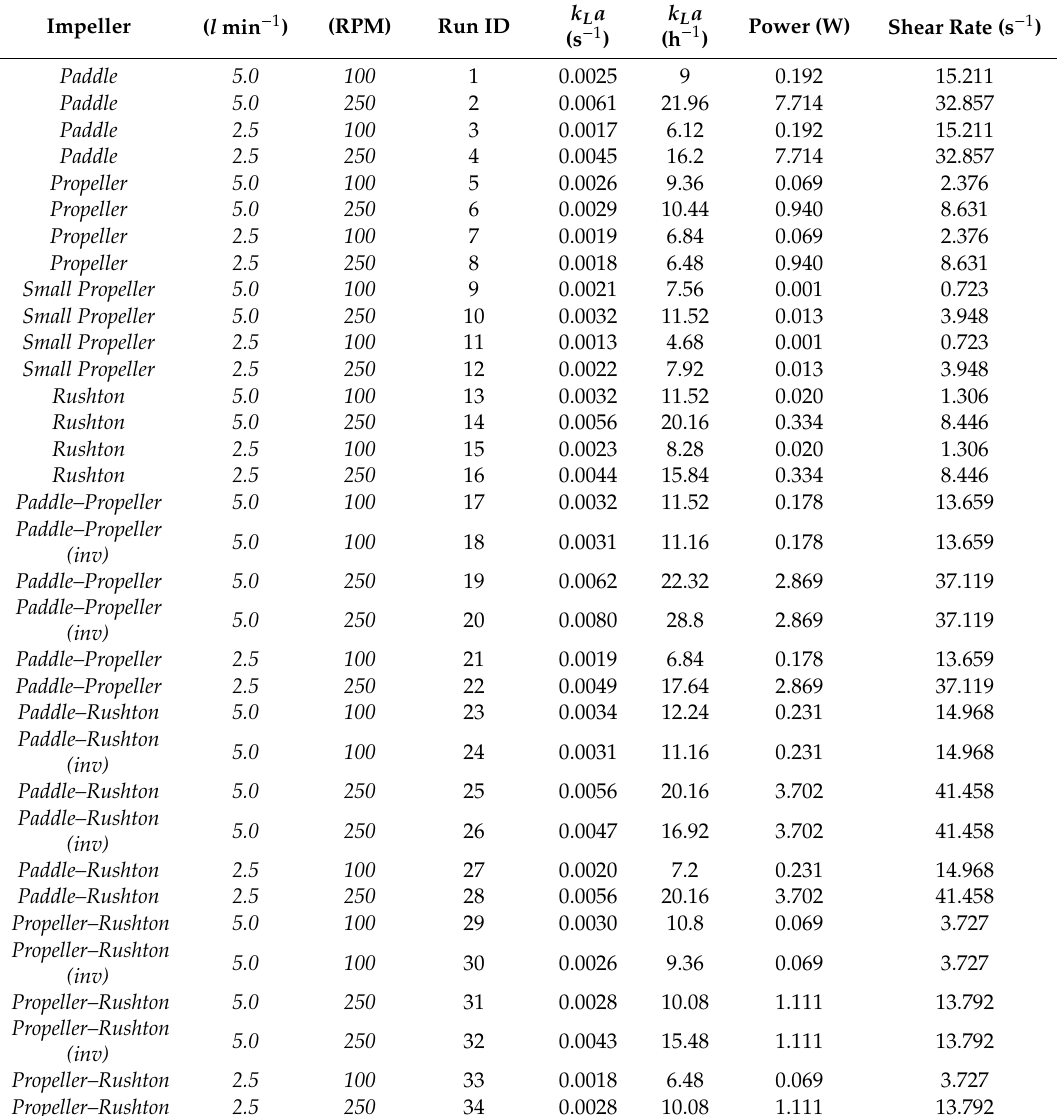
Table 6. k L a values, power and shear rate for di ff erent operational